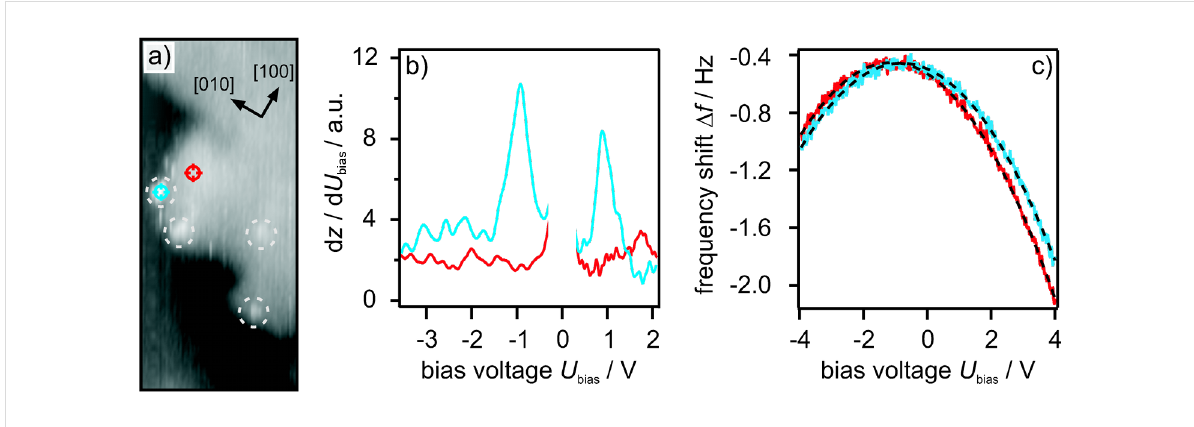
Figure 6: Spectroscopy on point defects. a) NC-AFM image of 21 nm × 9 nm measured at a frequency shift of Δ f = − 1.6 Hz , an oscillation amplitude of A osc = 0.34 nm and U bias = − 50 mV. Defects are indicated by circles. The position of the spectroscopy in b) and c) is indicated red and blue. b) STS on MgO. There are no states in the MgO- fi lm (red), whereas electronic defect states (blue) at approximately +1 V and − 1 V exist. c) Frequency shift vs bias voltage spectroscopy shows a quadratic dependence at the MgO- fi lm (red) and at the defects (blue). The maxima have different bias voltages.